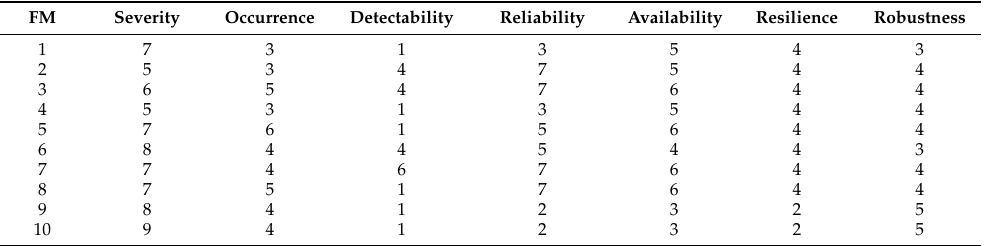
Table 5. Fan cowl doors repair project—risk and performance ratings using a 10-point scale. FM